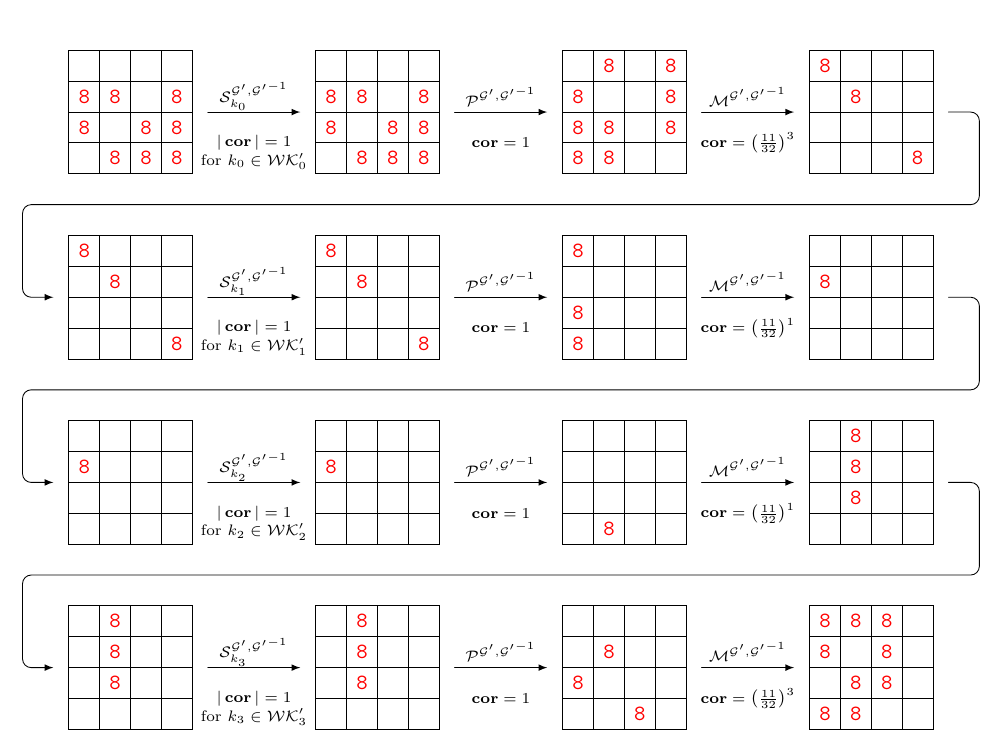
Figure 2: A probabilistic G 0 -shifted linear trail for four rounds of Midori64